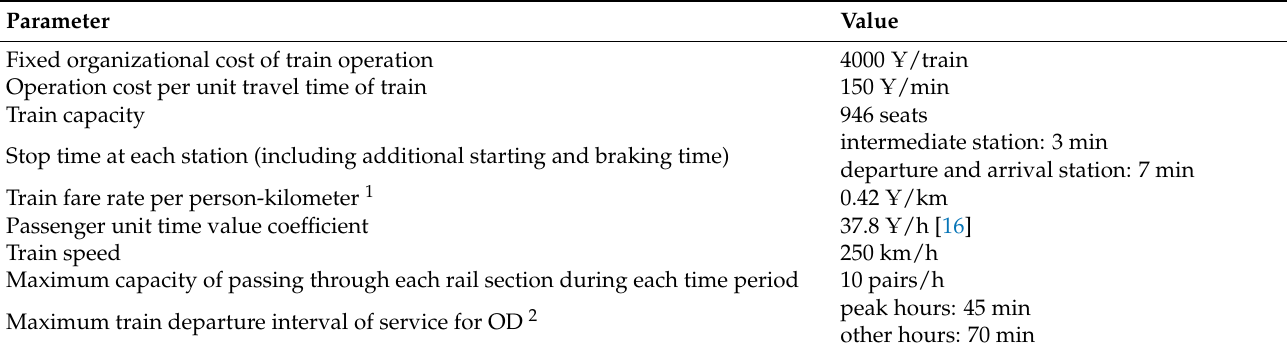
Table 3. The parameters related to train